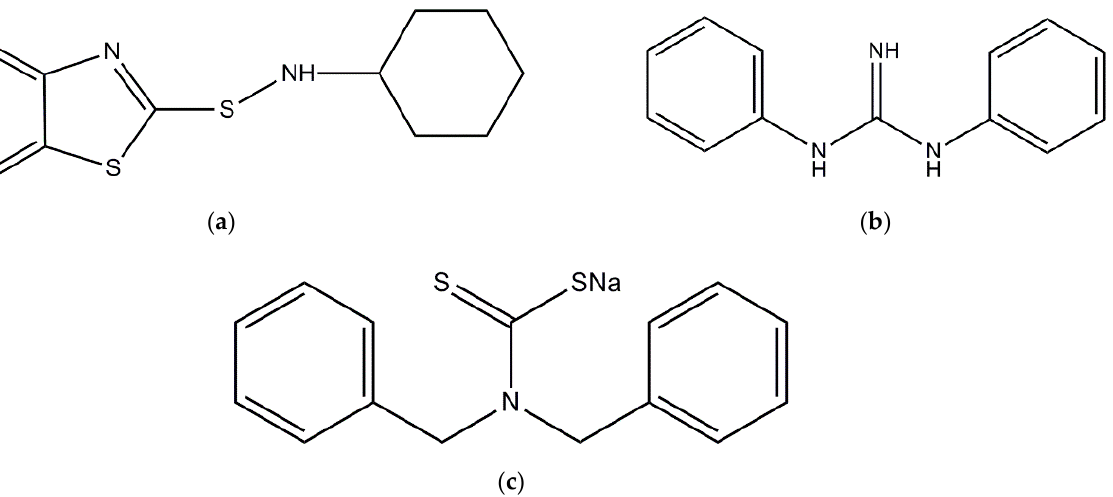
Figure 1. Structures of accelerators used in this study: ( a ) CBS; ( b ) DPG; ( c ) sodium dibenzyldithio- carbamate contained in Act8.